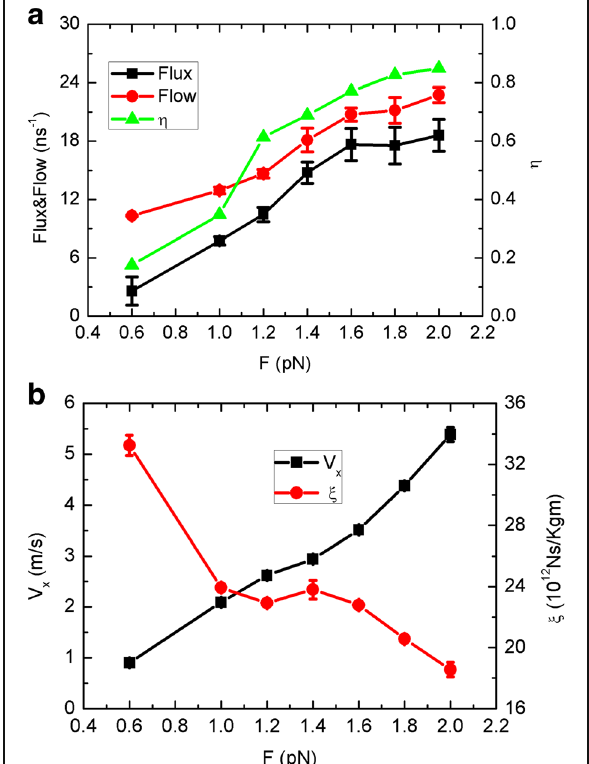
Fig. 6 a The water flux, flow, and unidirectional efficiency η and b the sheet velocity V x and friction coefficient ξ as a function of the driving force